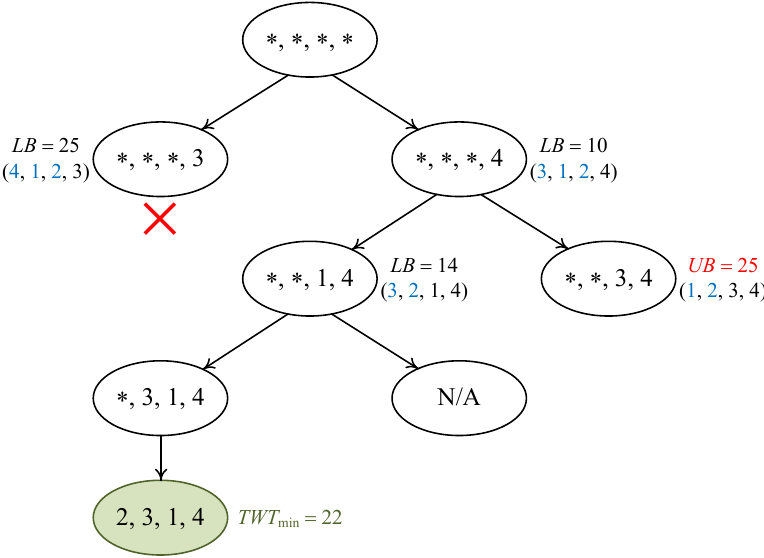
Figure 3. Example search process of the branch-and-bound